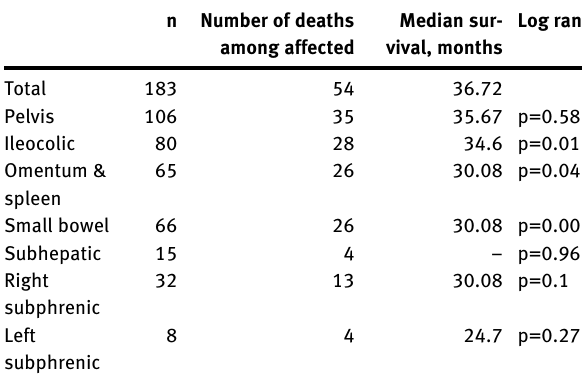
Table  : Median survival overall and for each of the seven sPCI region group.